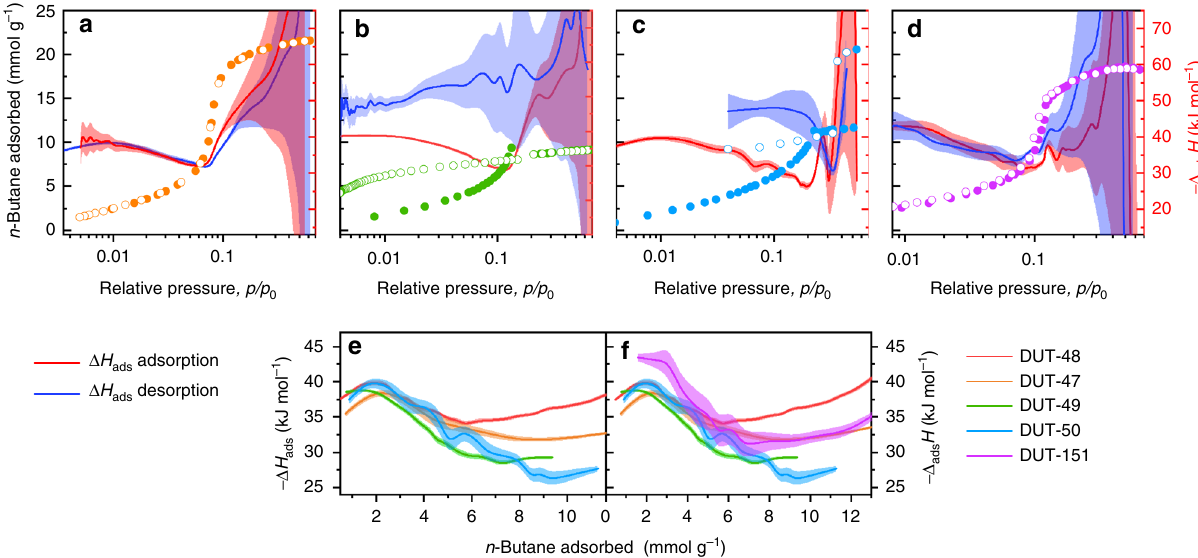
Fig. 3 Analysis of n -butane adsorption energetics. in situ calorimetric analysis in parallel to adsorption/desorption of n -butane at 303 K for a DUT-46, b DUT-49, c DUT-50, and d DUT-151 int . Adsorption and desorption in closed and open symbols, respectively, adsorption enthalpies red, enthalpy of desorption blue, error regimes indicated as coloured areas. e , f Adsorption enthalpies plotted against adsorbed amount of n -butane for the series non- interpenetrated MOFs ( e ) and in comparison with DUT-151 int ( f